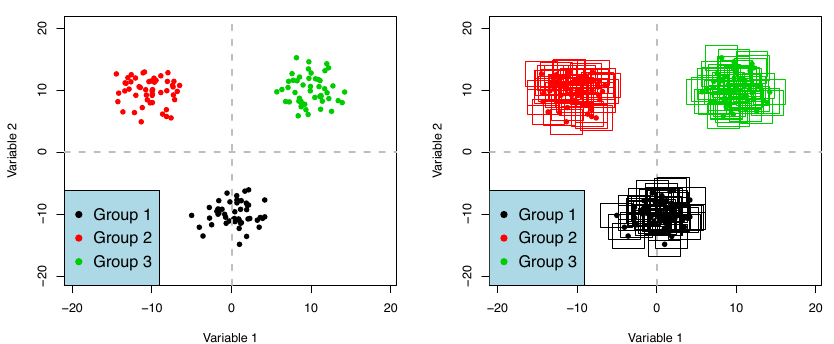
Figure 2. Partition identified by the EFC-ID model of an artificial interval-valued data. The clusters are highlighted through different